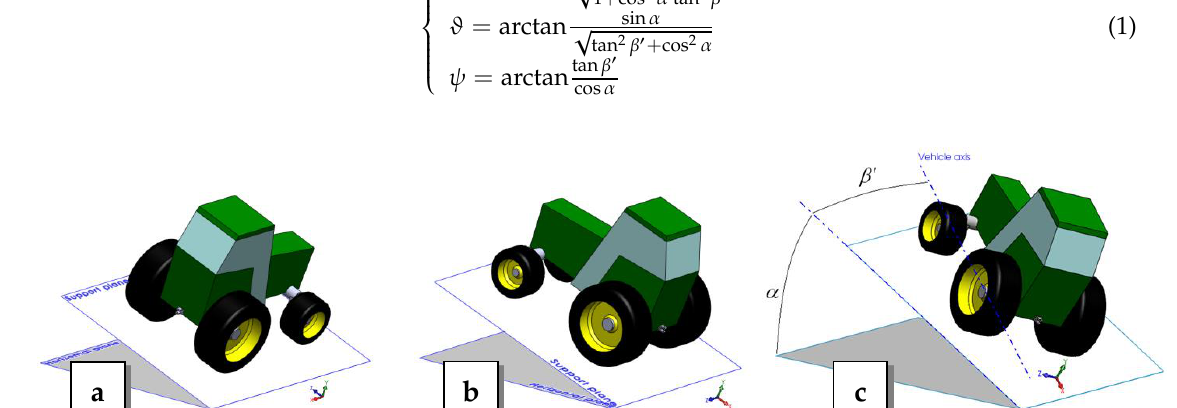
Figure 3. ( a ) lateral inclination of an agricultural machine, the imposed angle α corresponds to the roll angle φ ; ( b ) frontal inclination of an agricultural machine, the imposed angle α is the pitch angle ϑ ; ( c ) general inclination of an agricultural machine, the two set angles α and β′ impose angles of roll φ , pitch ϑ and yaw ψ to the vehicle under test.